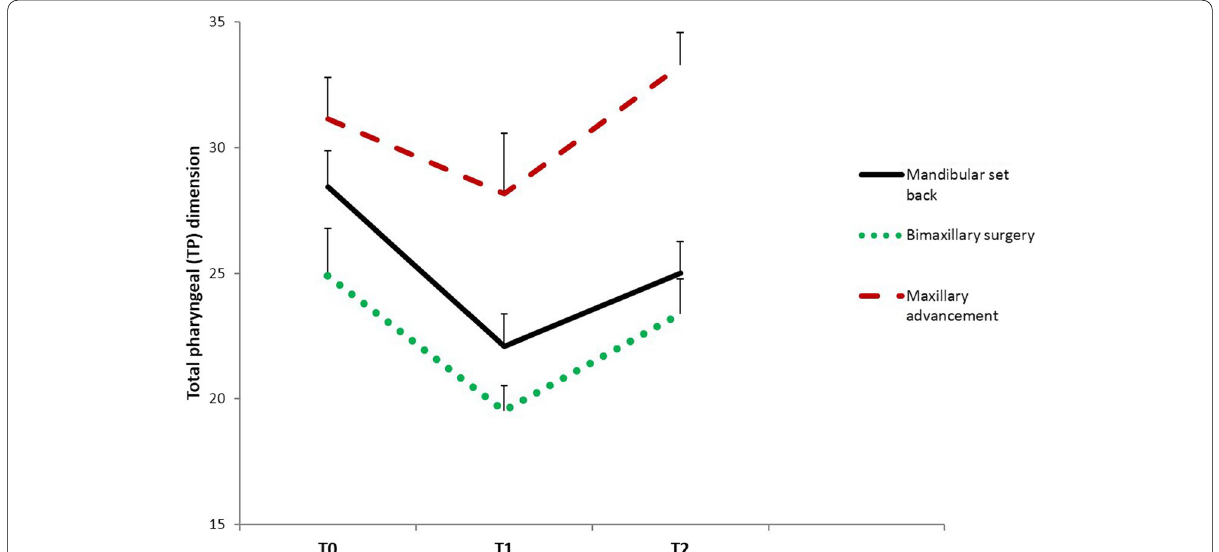
Fig. 3 A line chart representing variations in the total pharyngeal (TP) dimension in the study groups throughout the experiment. The alterations in the TP dimension were significant in all groups throughout the experiment ( P <